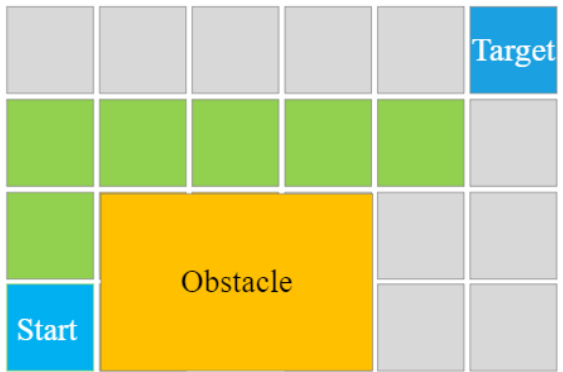
Figure 4. Simple example of the A*